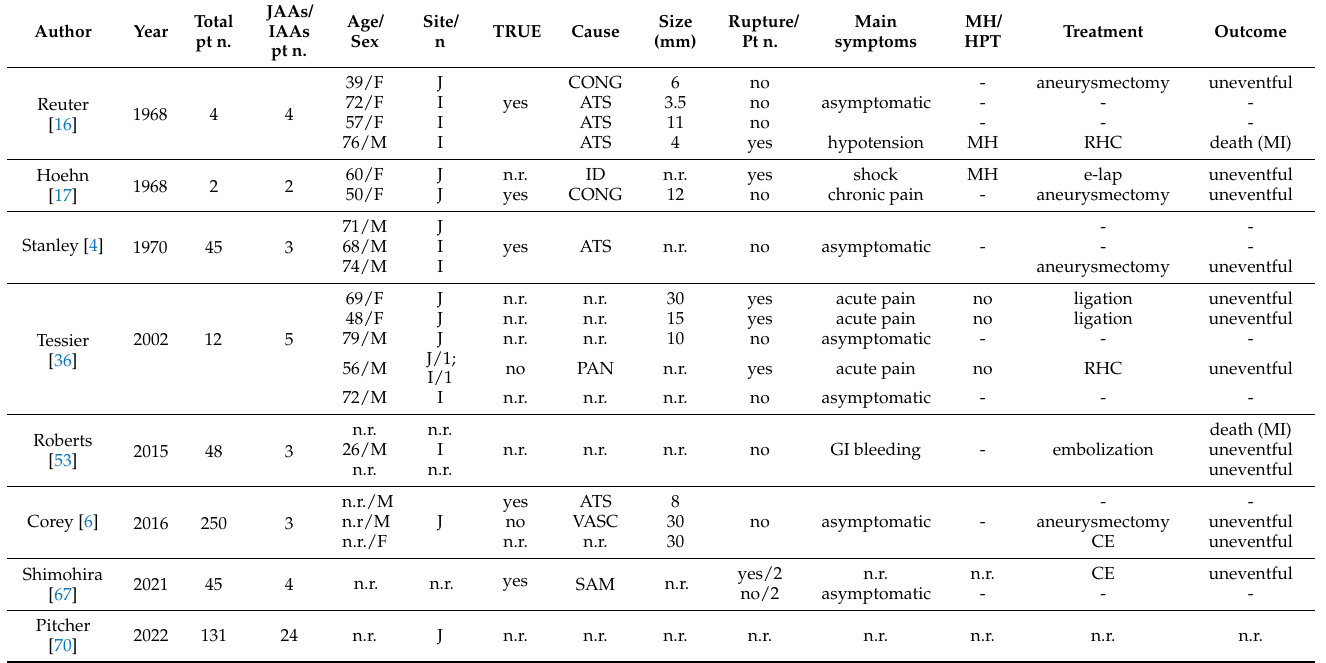
Table 1. Case series of JA and IA aneurysms including at least 2